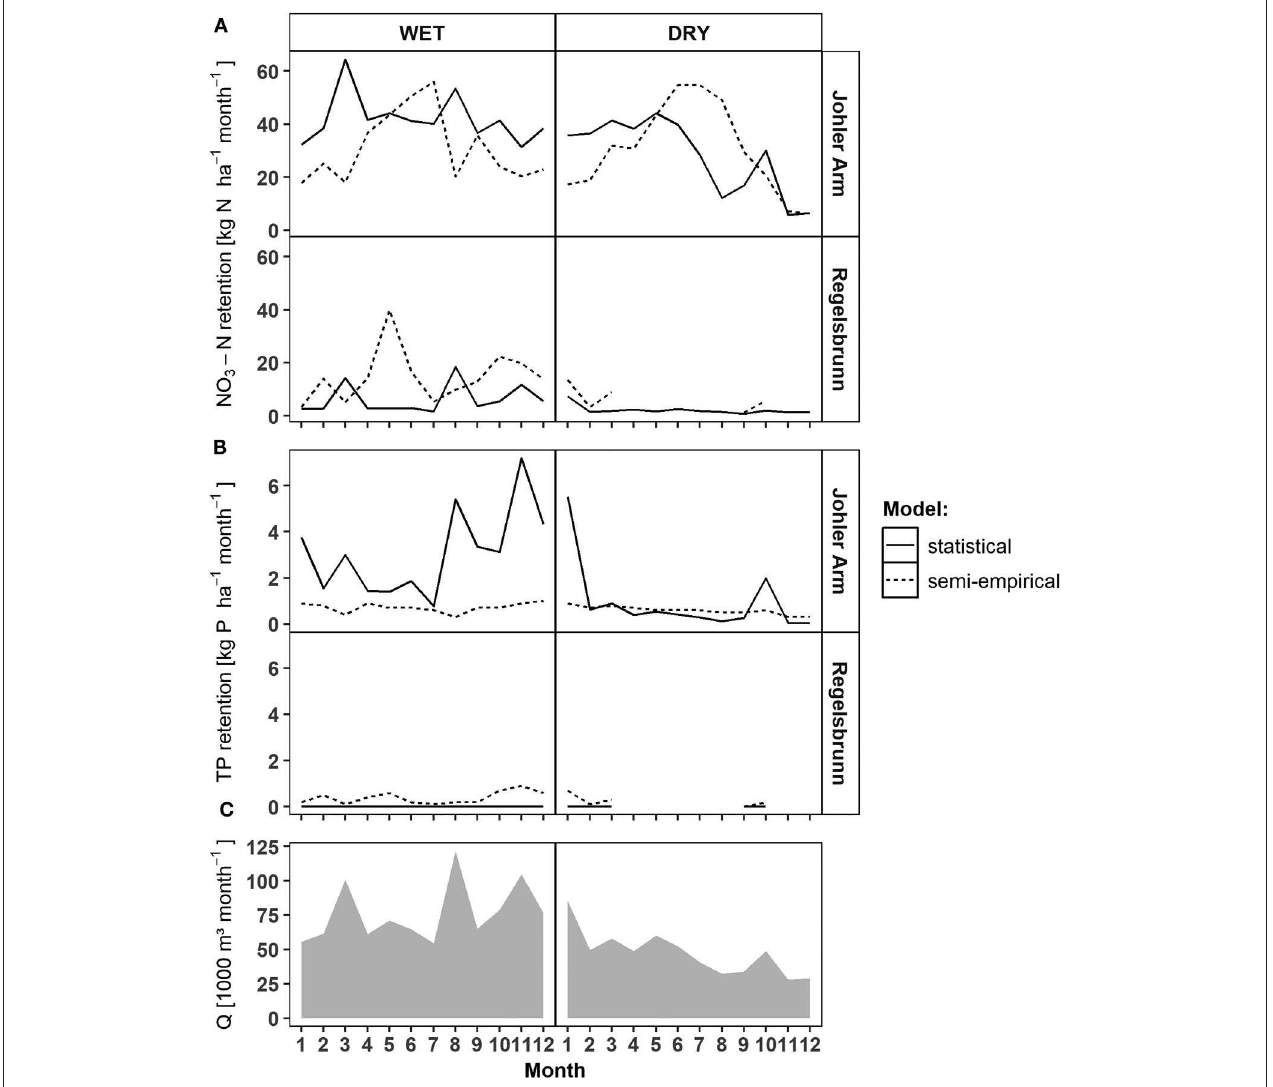
FIGURE 4 | Model comparison of monthly areal NO 3 -N (A) and TP (B) retention values below 5,130 m 3 s − 1 for the selected side arms Johler Arm (high connectivity) and Regelsbrunn (low connectivity), in which water quality data was available, as well as monthly discharge sums of the Danube River (C) . More detailed figures for all side arm systems, scenarios, and model years can be found in Supplementary Figures 2 , 3